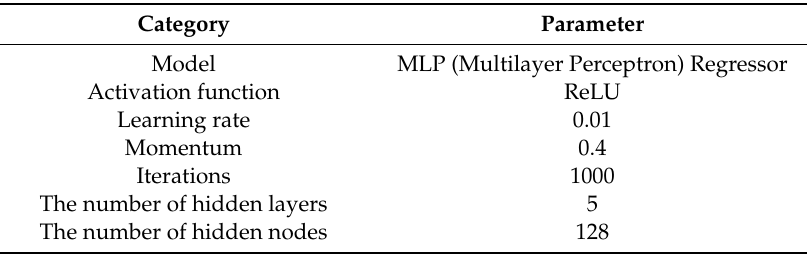
Table 7. Artificial neural network (ANN) model